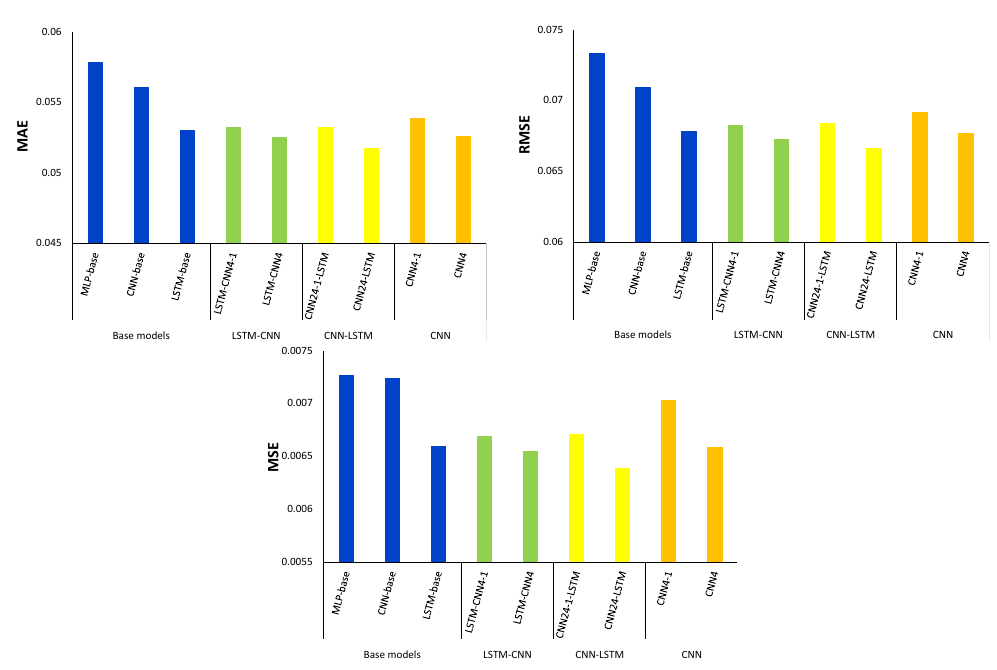
Figure 9. Yearly performance of the proposed and baseline models. Table 3. Monthly performance of the proposed and baseline models using three evaluation